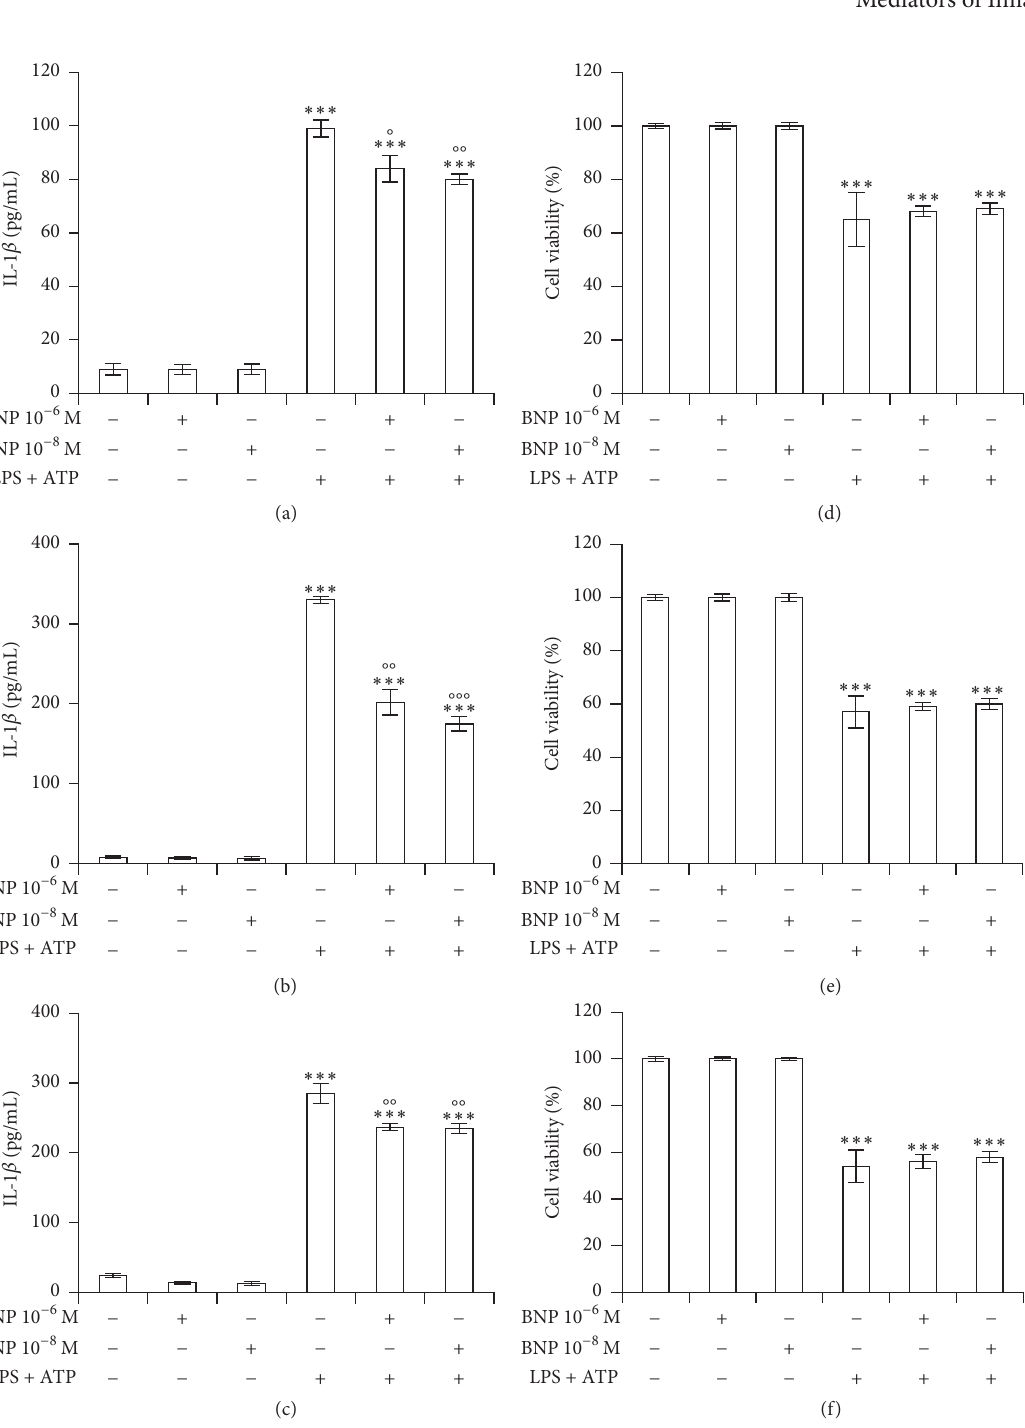
molecular platform whose activation triggers the